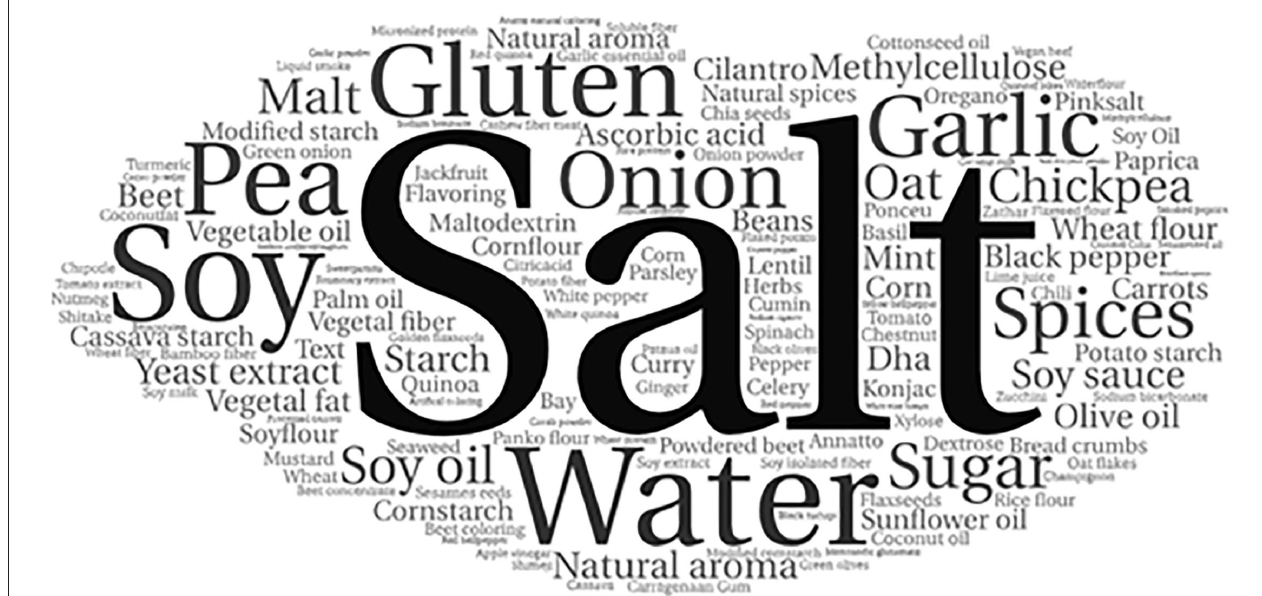
FIGURE 1 | Word cloud generated with the frequencies of implemented ingredients on vegan meat analogs. Higher frequencies were proportionally represented with more prominent graphic representations.